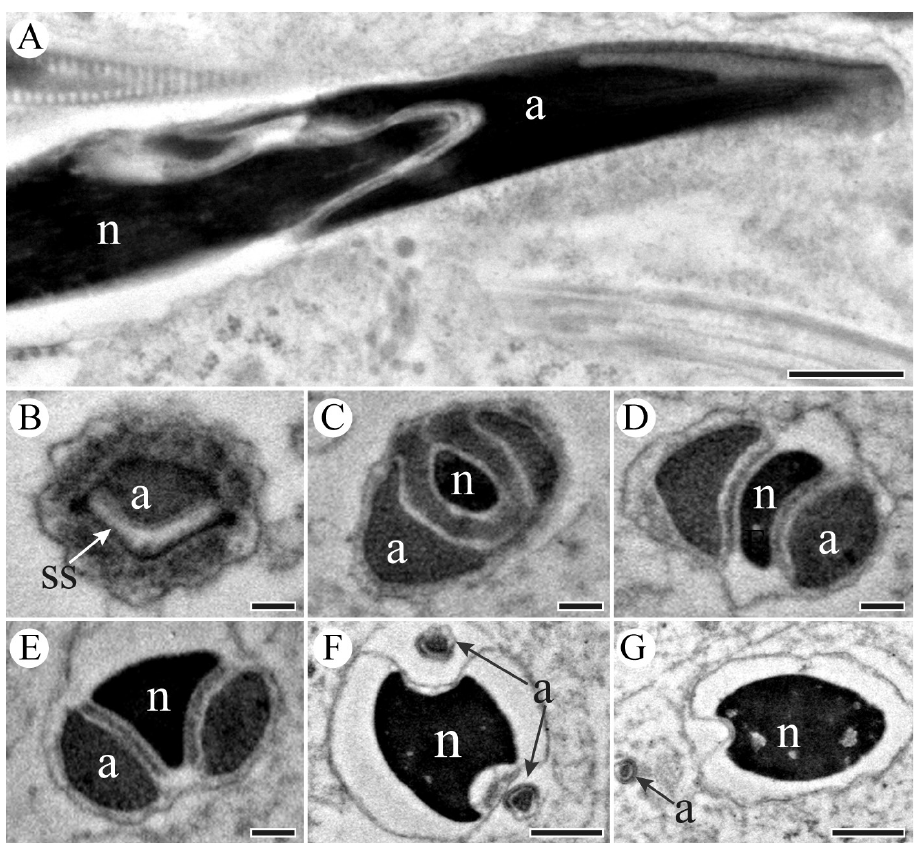
Figure 7. TEM micrographs of sperm head region of P. kaempferi . A Longitudinal section of sperm head, showing apex of acrosome (a), tapered nucleus (n) B Cross-section of the sperm head, showing acrosome (a) and subacrosomal space (ss) C–F Cross-sections of the sperm head, showing acrosome (a) and two acrosomal processes with numerous microtubules G Cross-section of the sperm head, showing nucleus (n) and an acrosomal process. Scale bars: 500 nm ( A ), 200 nm ( B–G